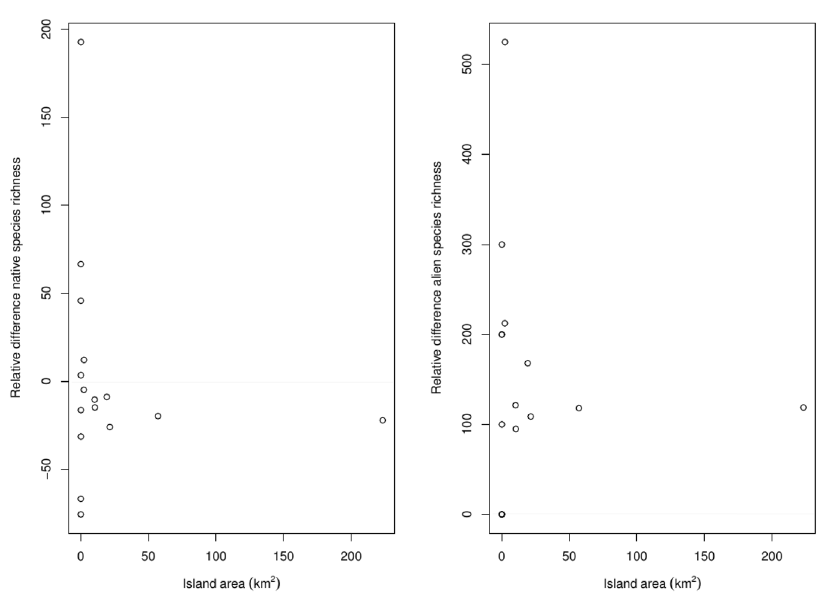
Figure 4. Relative changes in species richness of the first period (1830–1950) with respect to the second period (1951–2015) on each island of the Tuscan archipelago in relation to island area (n = 16) for native (left panel) and alien (right panel) species. Note that for the alien species graph some data points have identical values and thus